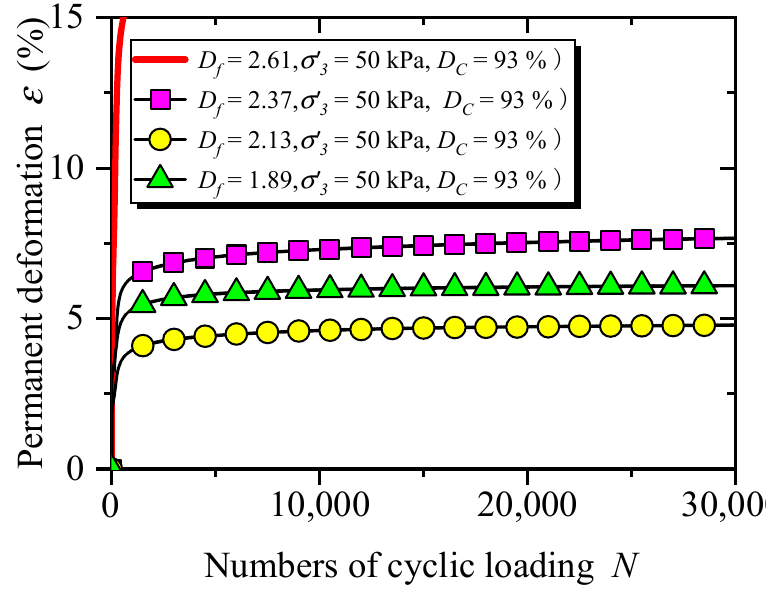
Figure 9. Relationship between ε and N with different grading parameters.